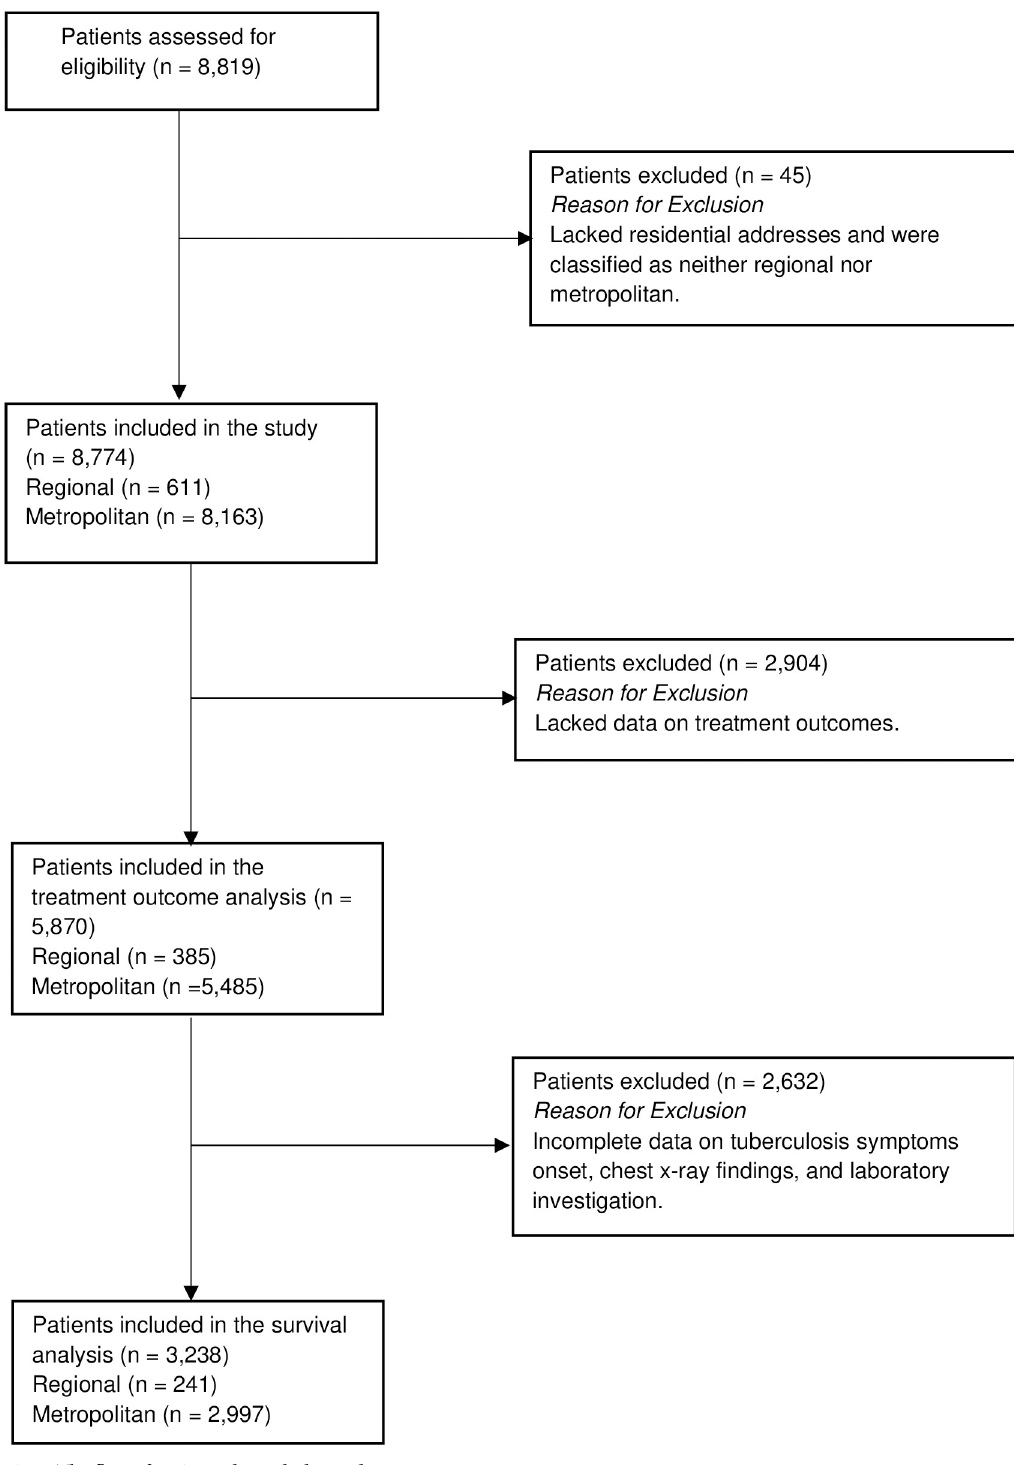
Fig 1. The flow of patients through the study.